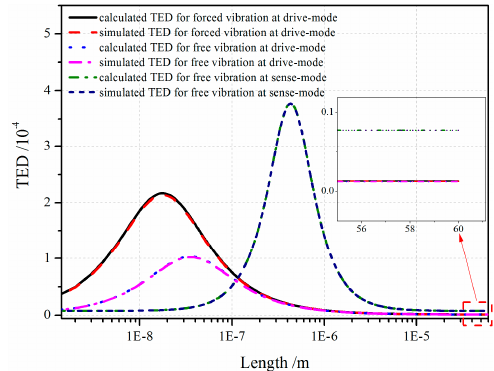
Figure 13. TED under different conditions.